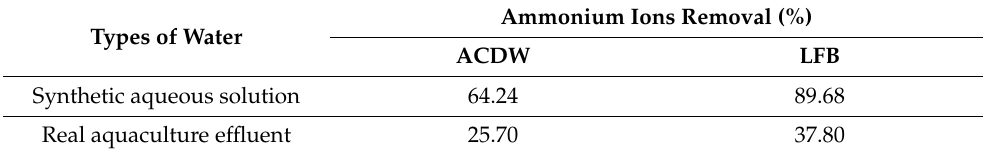
Table 1. Treatment for ammonium ions using ASDW and LFB in different water samples.